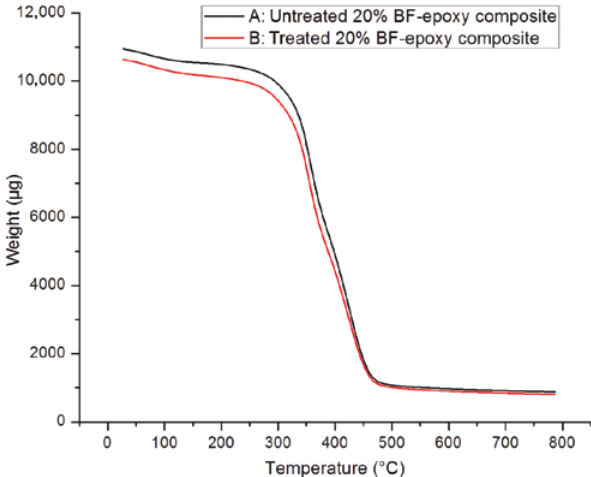
Figure 3: TGA thermogram of untreated and treated 20% BF-epoxy composites.